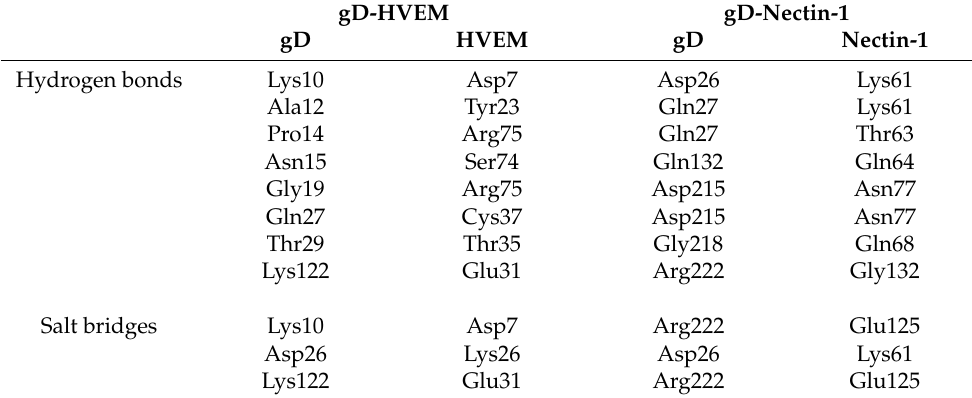
Table 3. Residues involved in the interaction of gD with HVEM and Nectin-1.